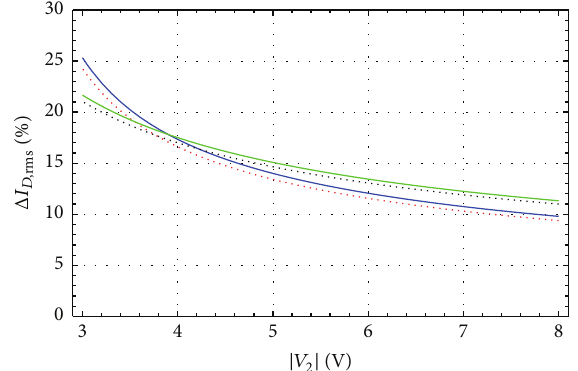
Figure 6: Triode and saturation regions P-type FGMOSFET based comparative plots of Δ𝐼 𝐷, rms ,𝑀 and Δ𝐼 𝐷, rms , SPICE against |𝑉 2 | where | = |𝑉 1